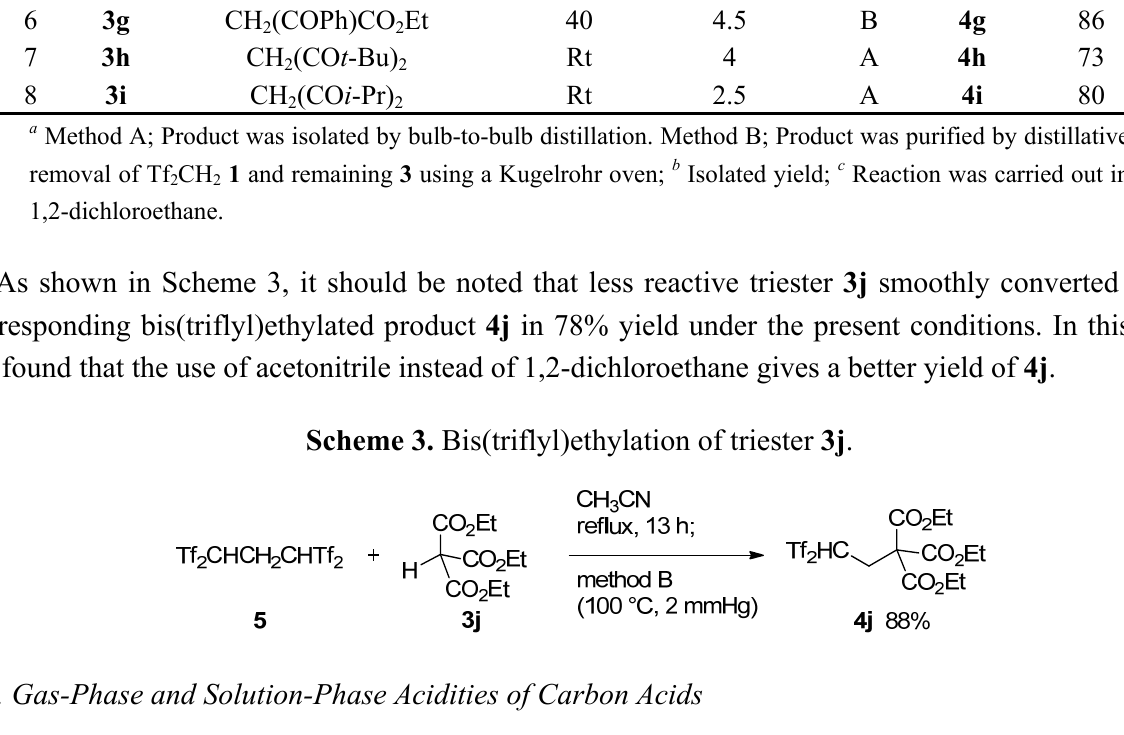
Table 1. Reaction of Tf